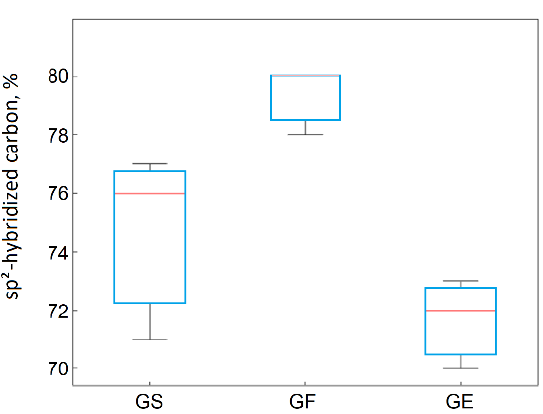
Figure 13. Box plot of C1sp 2 hybridization as a function of the applied precursor material.